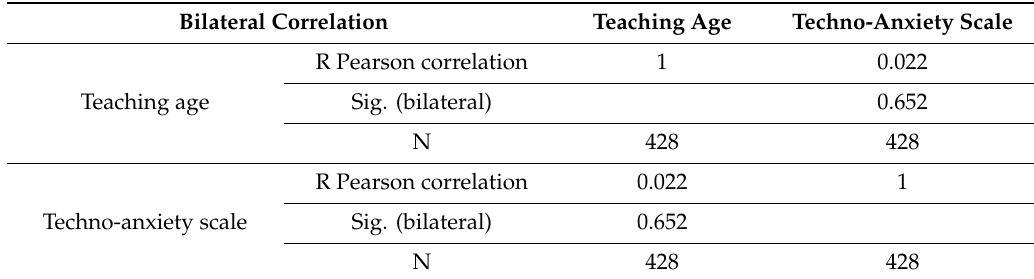
Table 4. Bilateral correlation between teaching age and techno-anxiety.